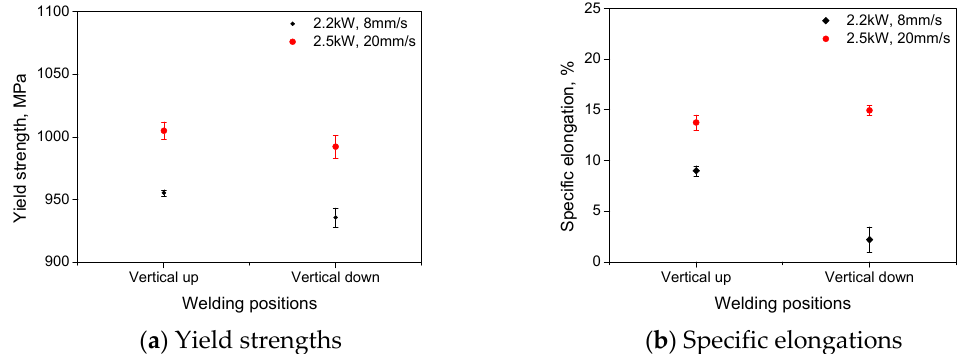
Figure 7. Tensile mechanical properties of laser joints made using different welding conditions.